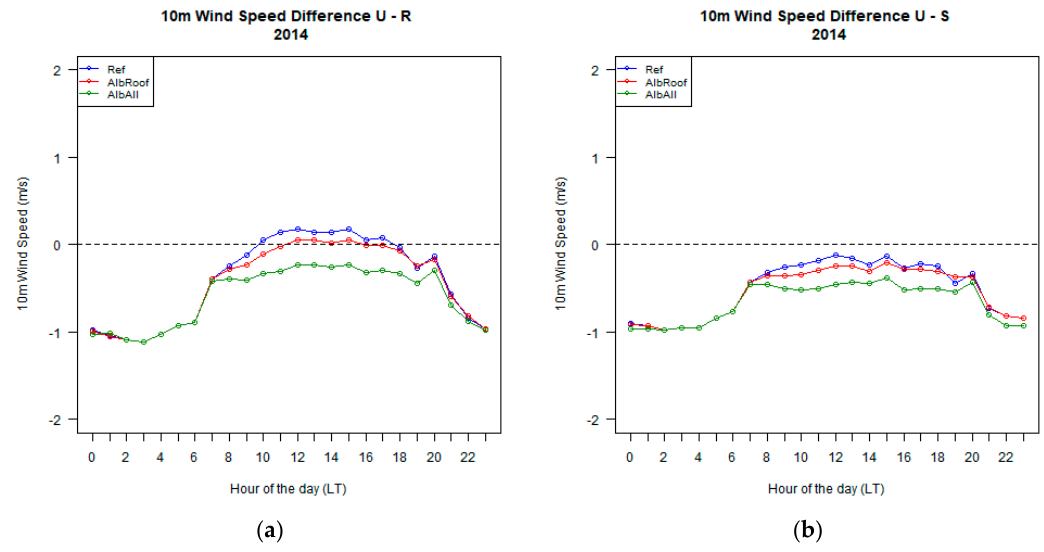
Figure 6. Same as Figure 3, but for wind speed at 10 m height: ( a ) Average 10 m wind speed difference computed over the mixed forest land use (Rural) category in Figure 1; ( b ) Average 10 m wind speed difference computed over the croplands land use (Suburban) category in Figure 1.